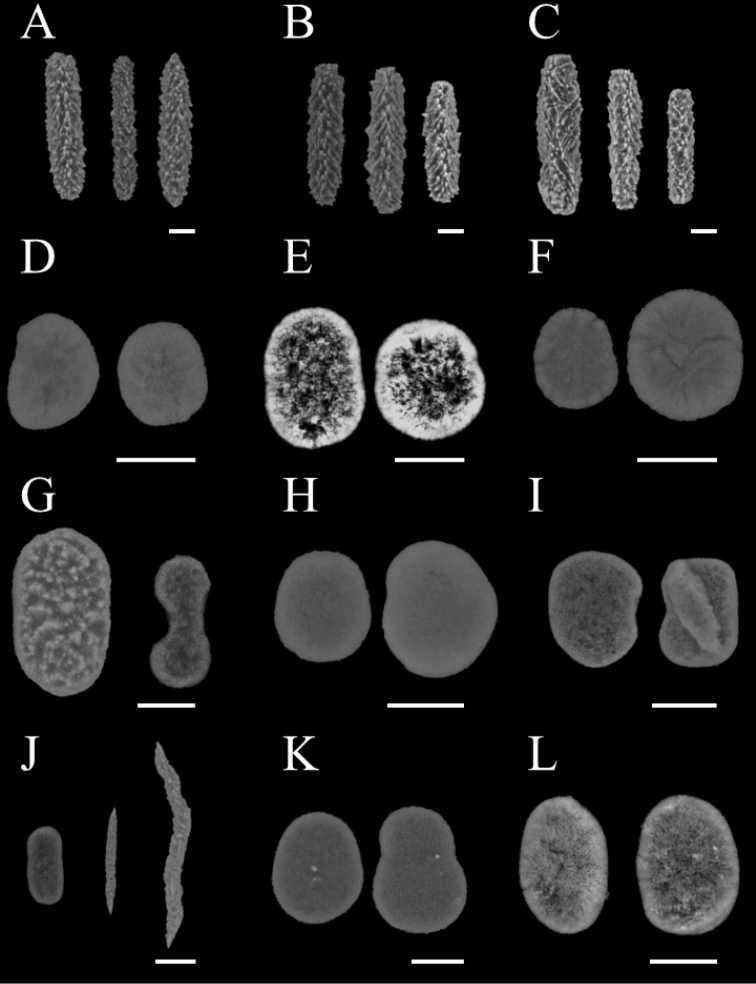
Scanning electron micrographs of sclerites of Xeniidae. AAntheliacf.glaucaBA.roseaCA.cf.tosanaDHeteroxeniacf.elisabethaeEH.medioensisFH.minutaGSympodium. sp. 1 HS. sp. 2 IYamazatum sp. 1 JXenia sp. 1 KX. sp. 2 LX.plicata. Scale bar: 10 μm.